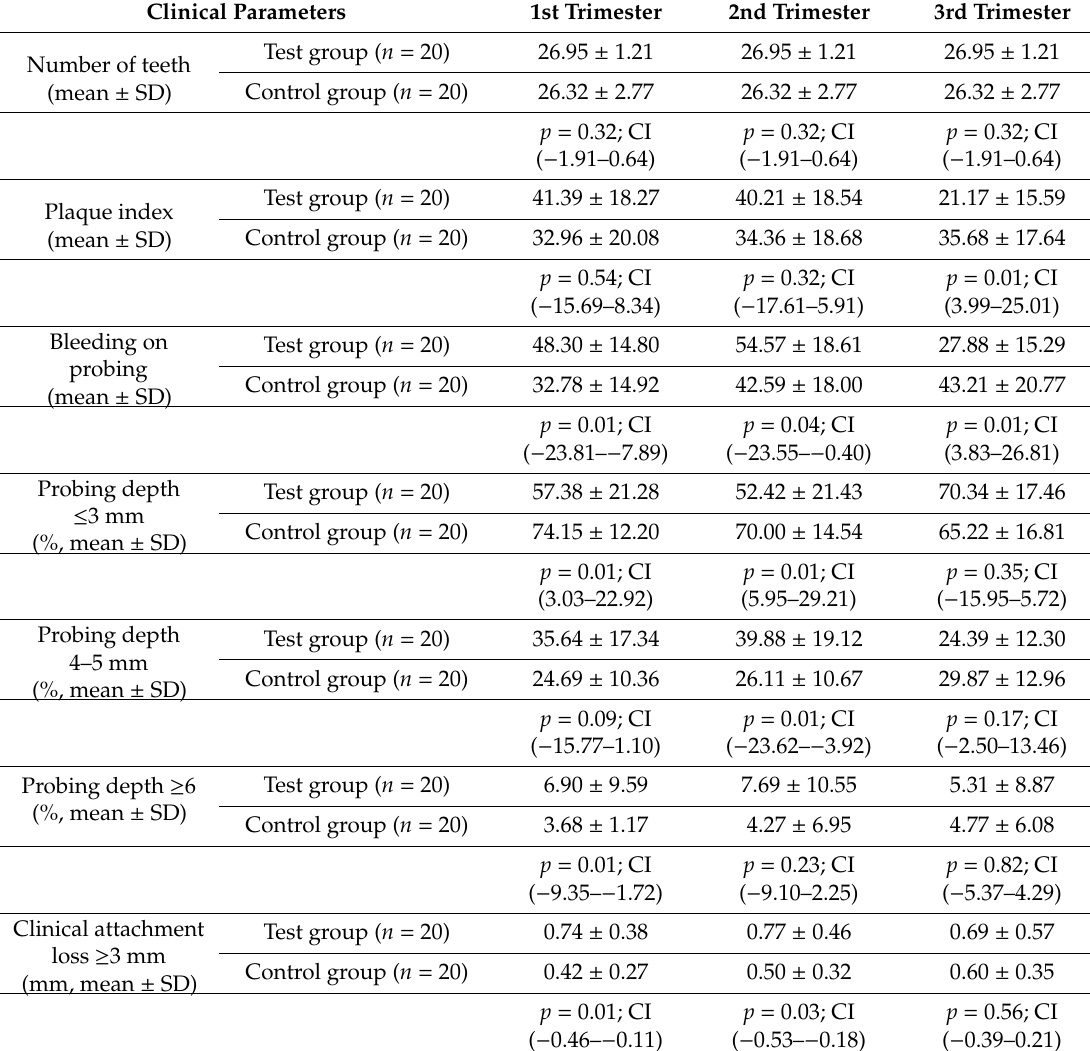
Table 2. Evolution of clinical parameters during